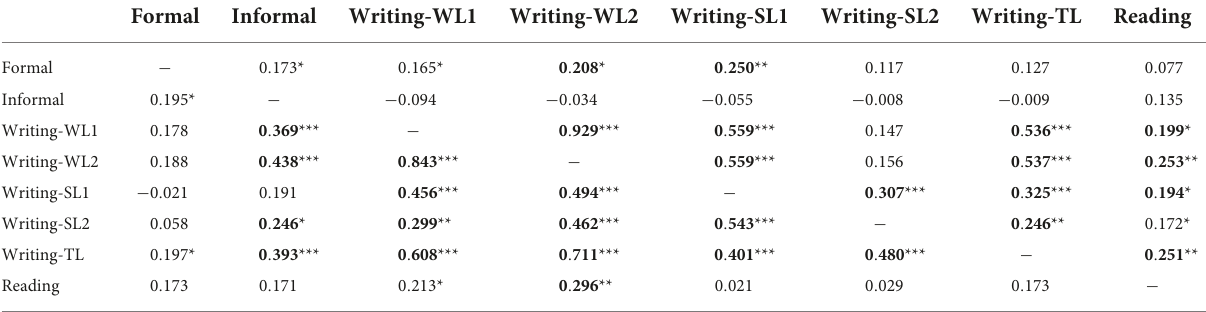
TABLE 2 Partial correlations among home literacy environment (HLE), writing, and reading measures controlling for age and